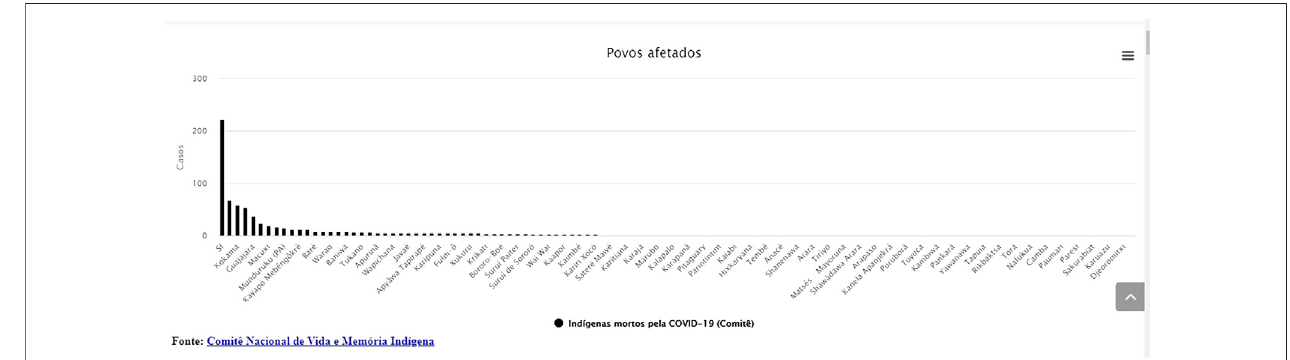
FIGURE 4 | Comit ˆ e Nacional de Vida e Memória Indígena